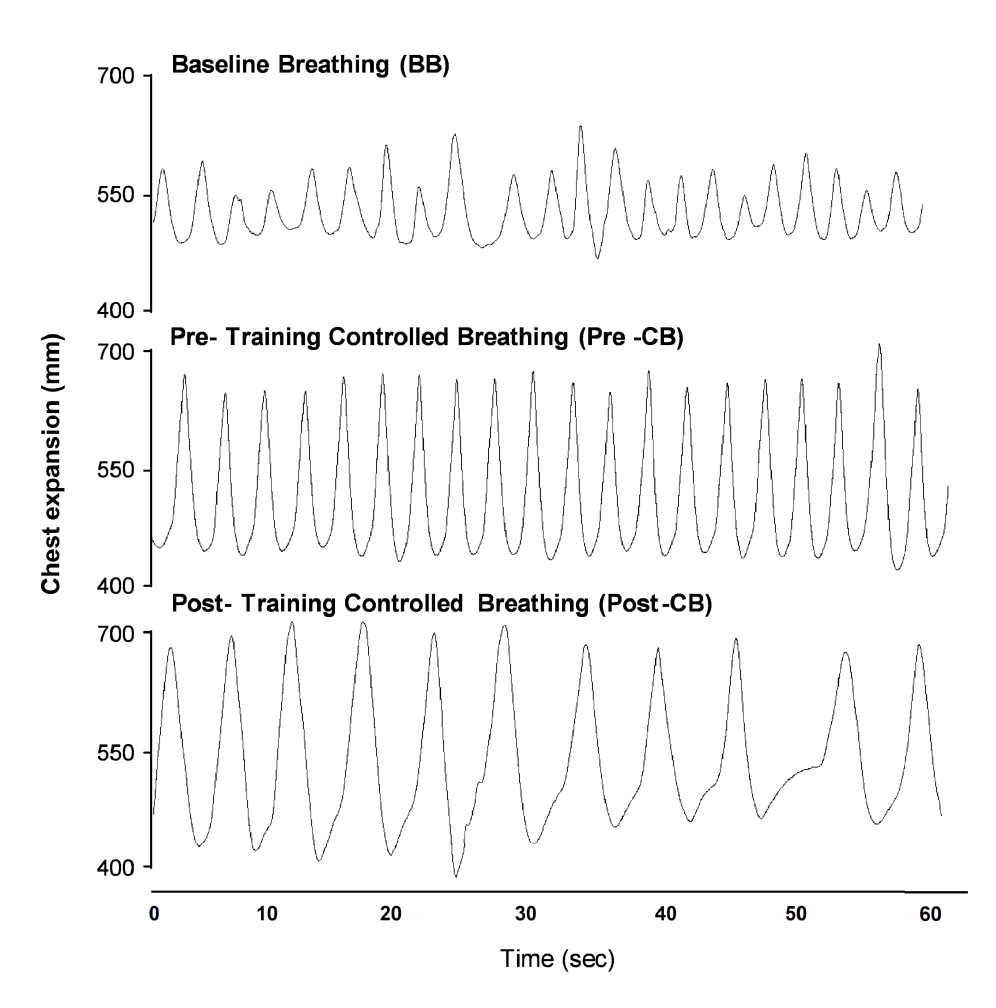
Fig 5. Representative biometric respiratory recording. Representative data captured using LabChart software and an Equivital respiratory harness, recorded at baseline (BB) and after being prompted to engage in controlled breathing task before (Pre-CB) and after training